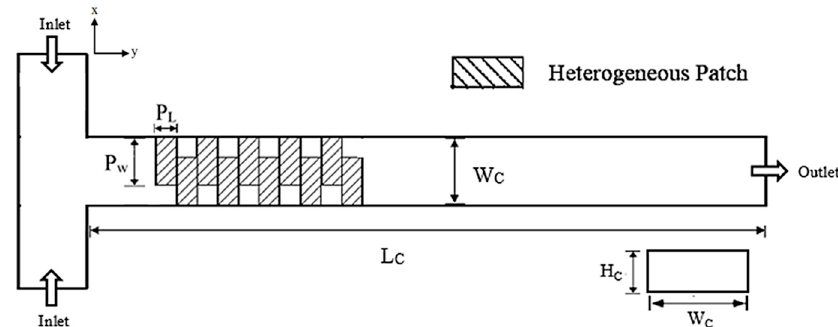
Figure 1. Schematic diagram and geometric parameters.